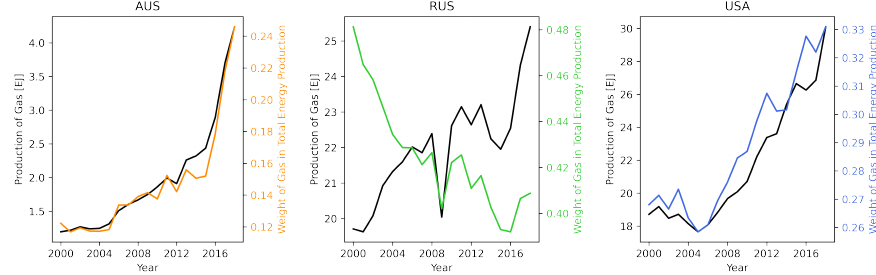
Figure 23. The evolution of natural gas production and its share in total energy mix.